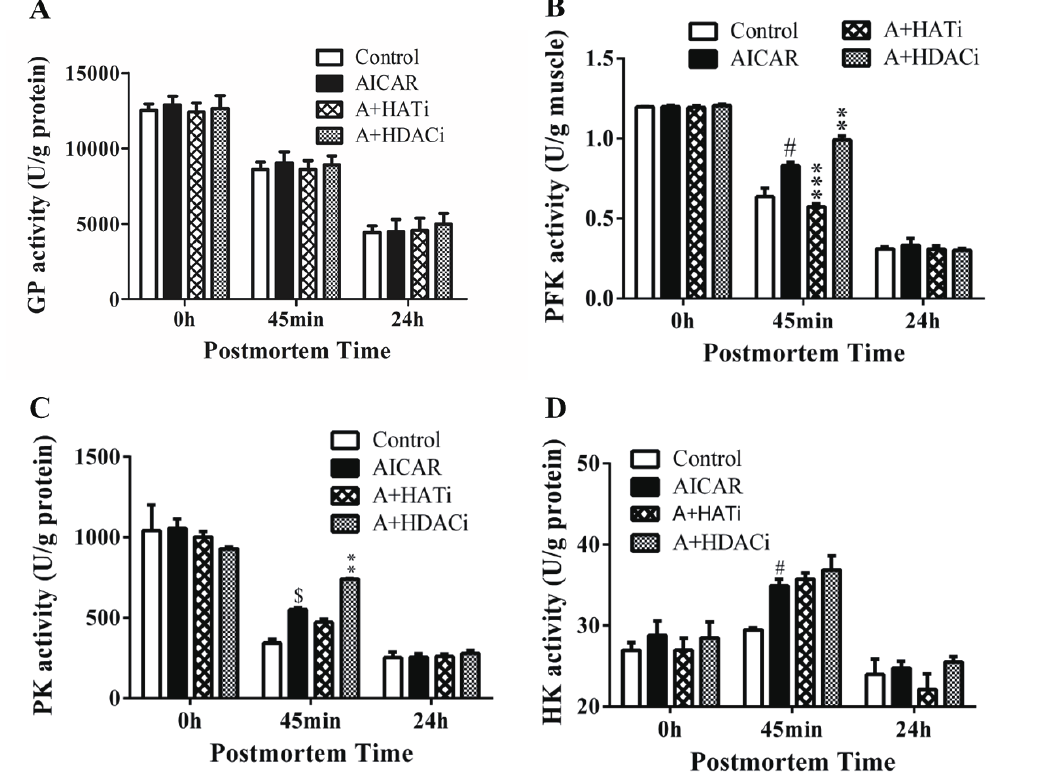
Figure 3. Activities of glycogen phosphorylase a (A), phosphofructokinase (B), pyruvate kinase (C) and hexokinase determined in postmortem muscles. AICAR, 5-Aminoimidazole-4- carboxamide1- β -D-ribofuranoside; A+HATi, AICAR plus histone acetyltransferase inhibitor II; A+HDACi, AICAR plus histone deacetylase inhibitors. # p<0.05 and $ p<0.01 compared with control group; ** p<0.01 and *** p<0.001 compared with AICAR-injected group. n = 8.